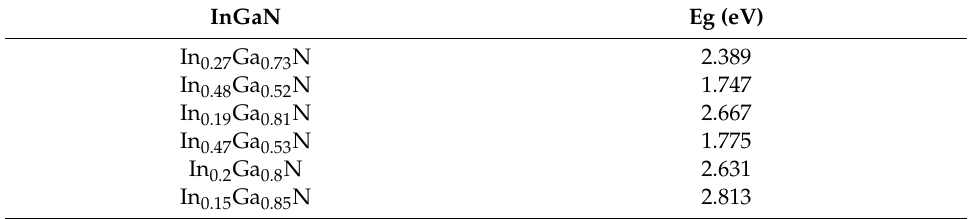
Figure 3. XRD results of four samples. Table 1. Relationship between In concentration of In x Ga 1-x N and band gap.